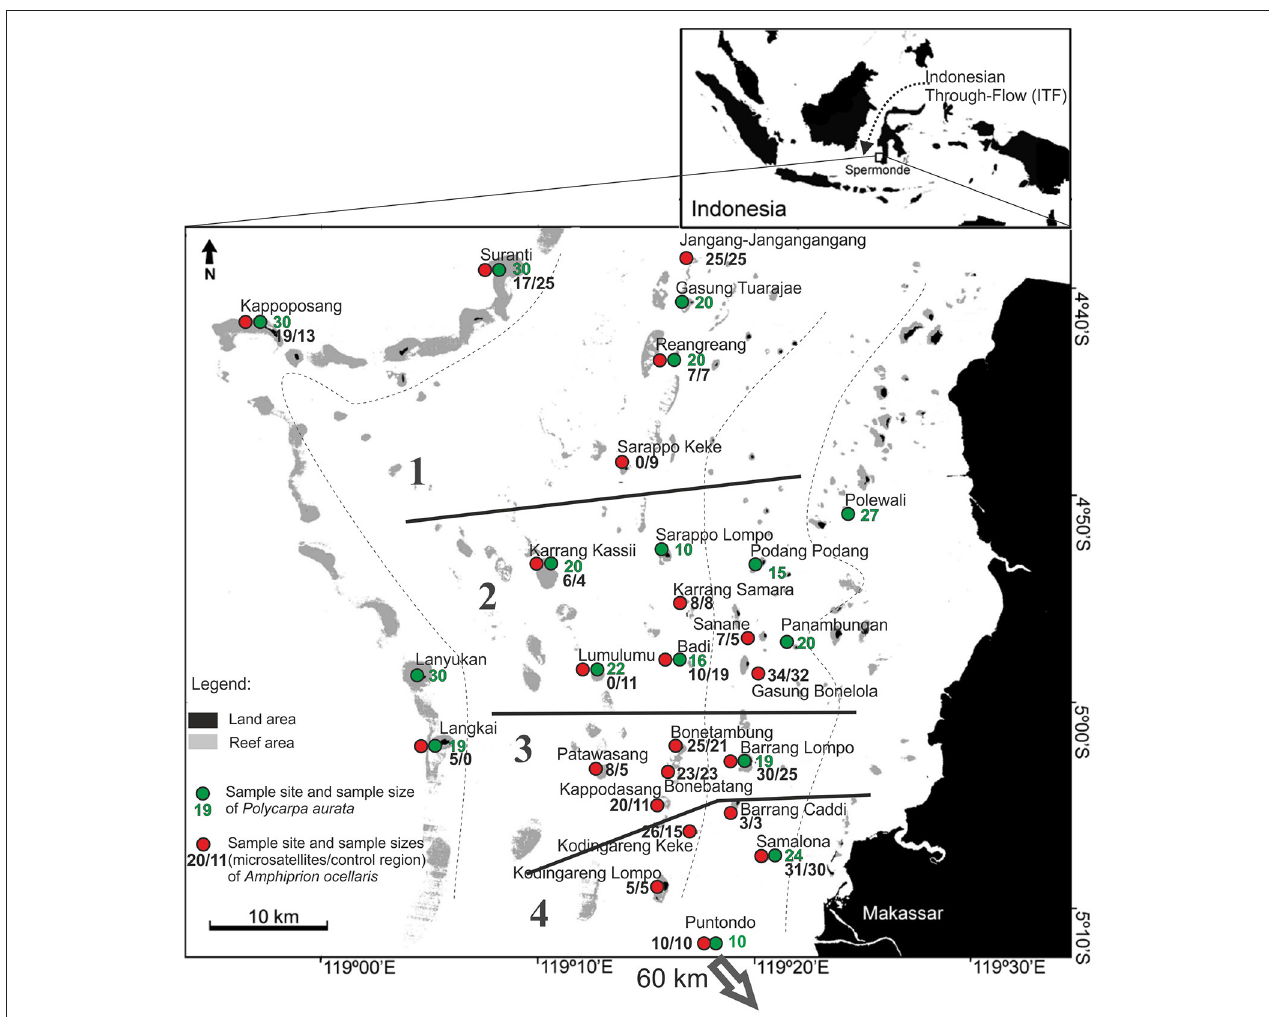
FIGURE 1 | Sample sites for the clown anemonefish, Amphiprion ocellaris , (red circles) and the solitary sea squirt, Polycarpa aurata , (green circles) with corresponding sample sizes for each location in Spermonde Archipelago, Indonesia. Regional groups (1–4) tested for significant differences in nucleotide diversity are indicated on the map through solid black lines. Dashed lines are the major isobaths found on the shelf (simplified after Cleary et al., 2005). Puntondo is located 60 km South of Spermonde on the coast of Sulawesi.